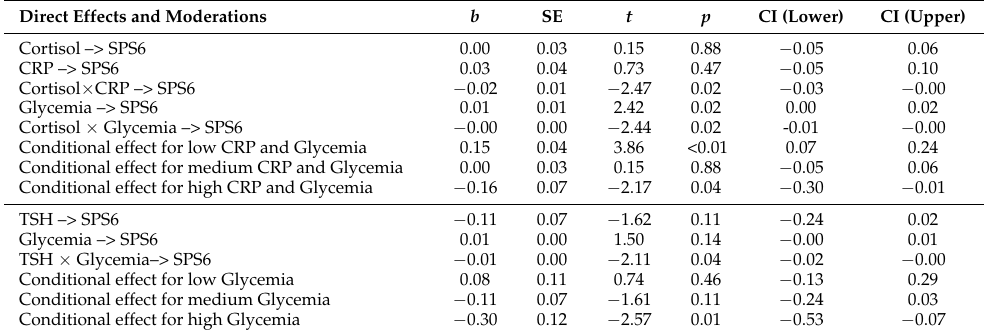
Table 3. Multiple regression analyses and moderation effects explaining the relationships between both biomarkers and hormones and productivity despite illness.